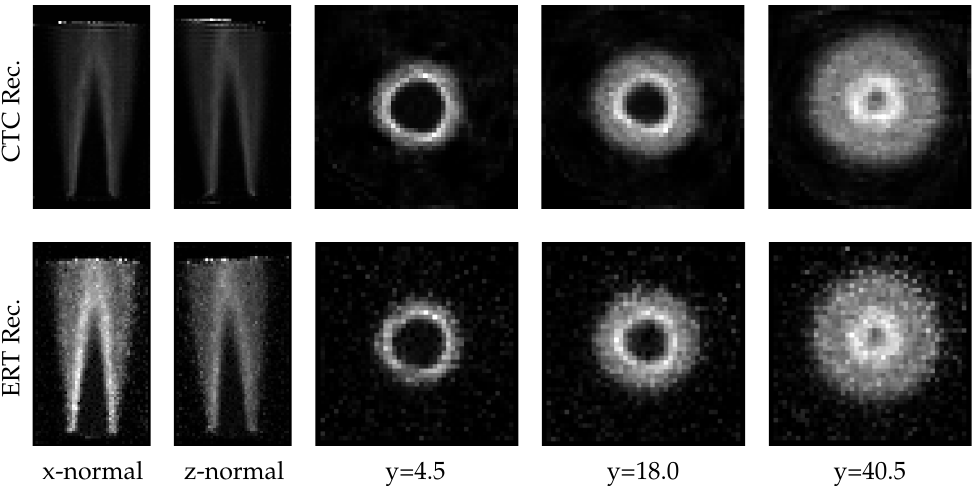
Figure 13. Vertical slices at the flame center (x-normal and z-normal), and horizontal slices at different heights above burner exit (in